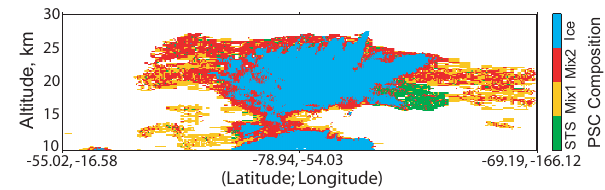
Fig. 11. Daily time series of CALIPSO PSC area as a function of altitude for the (a) 2006, (b) 2007, and (c) 2008 Antarctic seasons. The total volume PSC coverage for all three seasons is shown in panel (d)